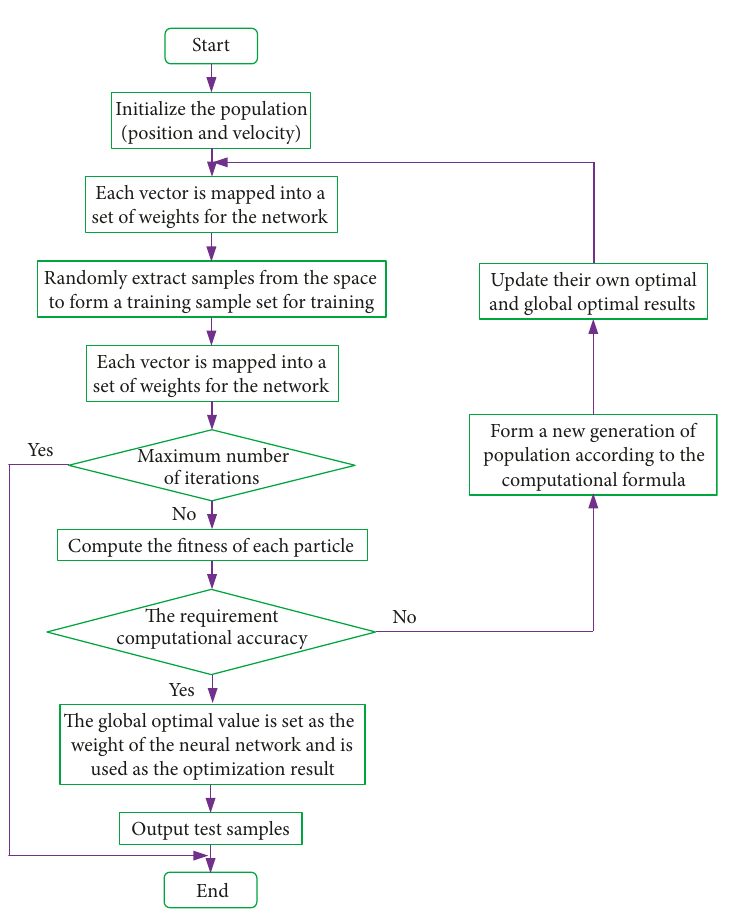
Figure 11: Flow chart of PSO-BP neural network model.